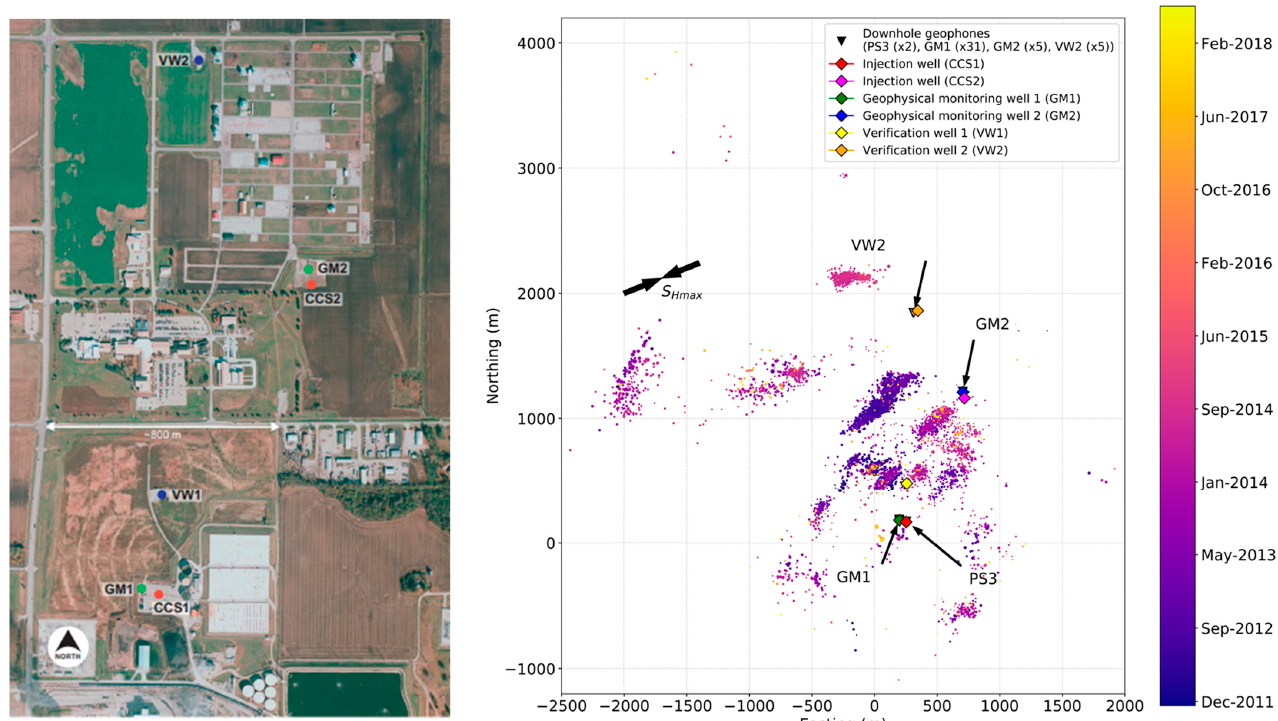
Figure 7. IBDP project site monitoring system and event distribution (cited in Bauer et al., 2019 [50] and D E Dando et al., 2021 [51]).